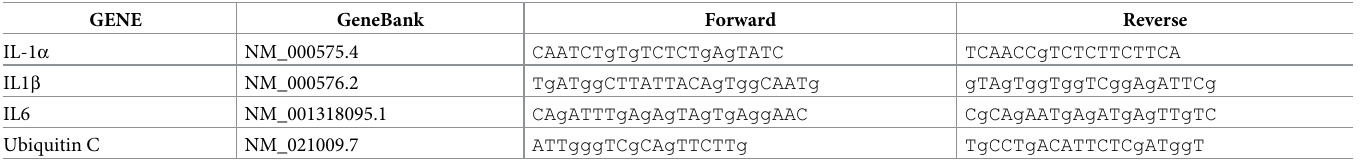
Table 2. Primer sequences used for real time quantitative polymerase chain reaction analysis.